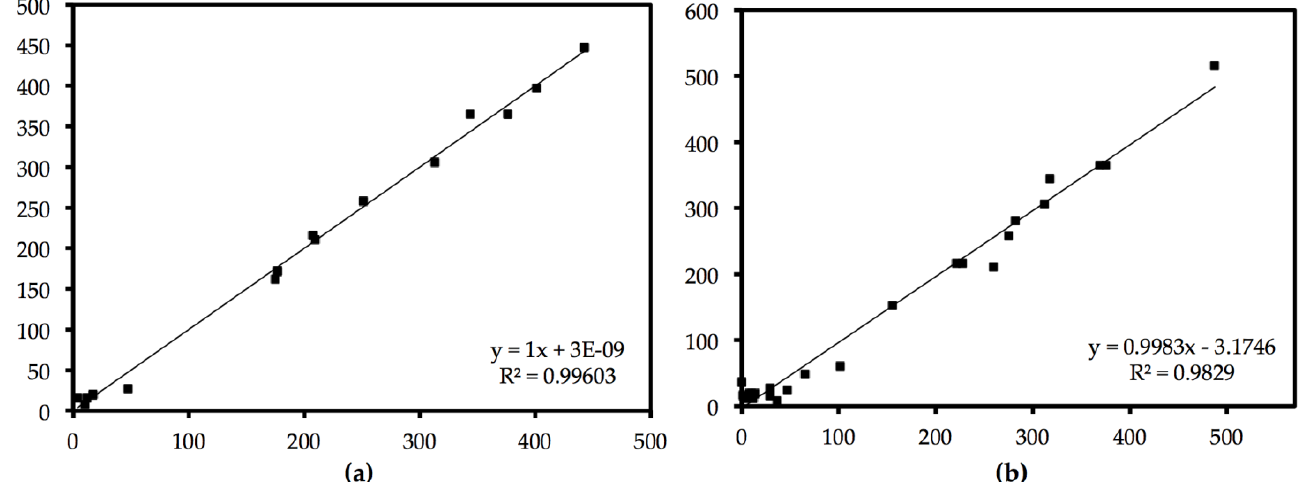
Figure 2. Training dataset comparison. Least-square line equation and the square of the linear correlation coefficient are also shown for ( a ) Hoke D6 design and ( b ) composite factorial design. Both axes represent b in Ws 1/2 m −2 K.